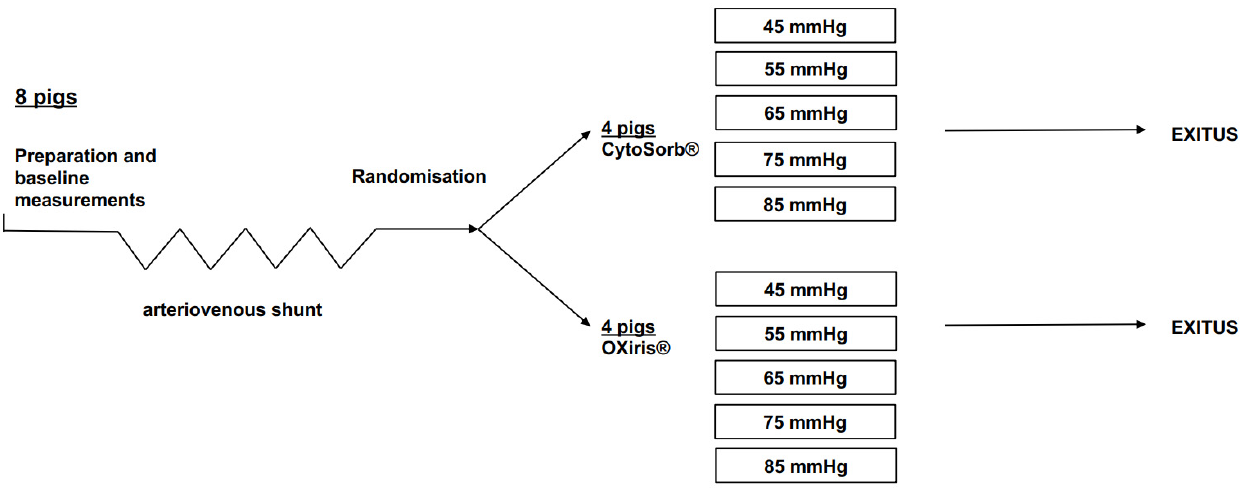
Figure 1. Experimental timeline. After baseline preparation, an arteriovenous shunt was established in eight pigs between the femoral artery and femoral vein. In all pigs, an extracorporeal HA device was inserted into the shunt circulation with blood flowing from the femoral artery through the adsorber into the femoral vein. The animals were randomly assigned to one of the two treatment groups (n = 4/group). MAP was varied between 45 mmHg and 85 mmHg in incremental steps of 10 mmHg every 20 min using continuous intravenous infusions of noradrenaline or urapidil.